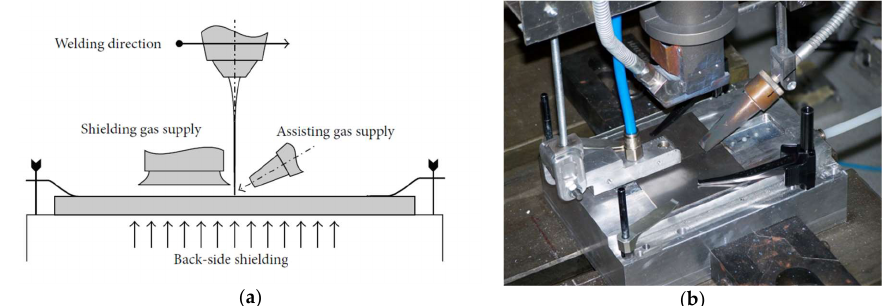
Figure 1. ( a ) Laser welding system scheme and ( b ) gas shielding system picture.